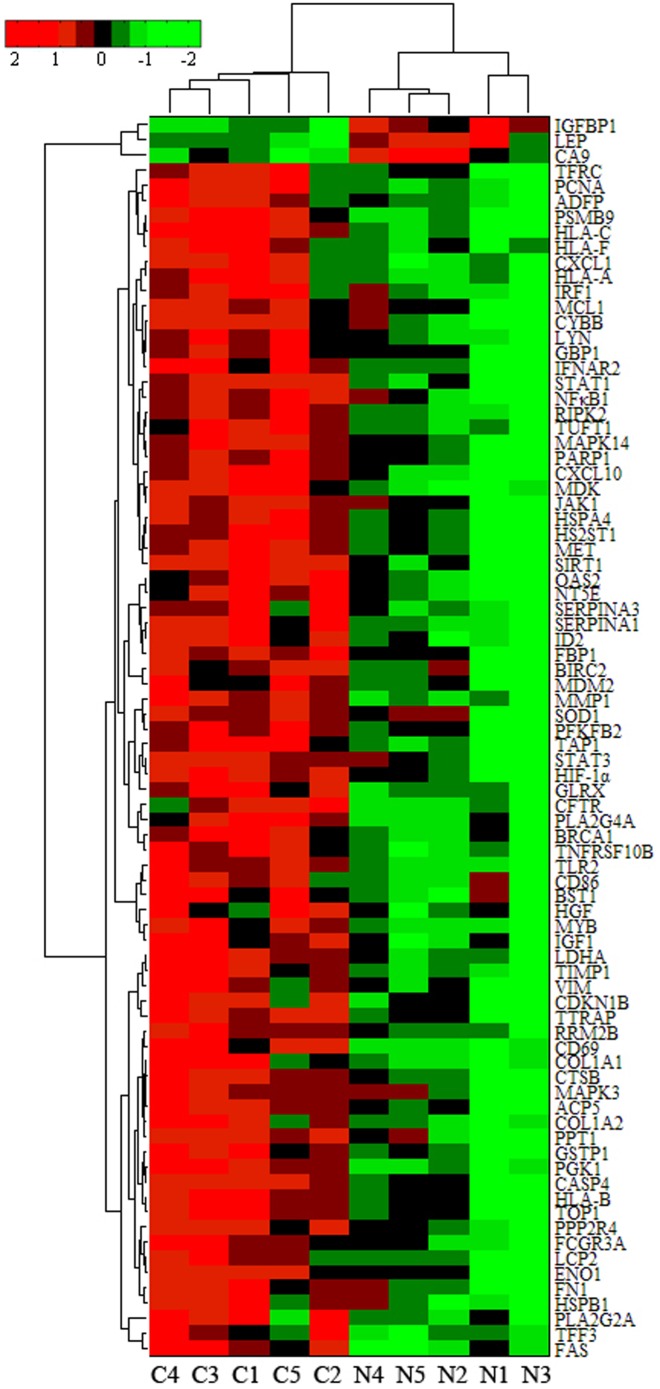
The bi-clusters analysis of these 82 differentially expressed genes in TF-gene regulatory network.Each row represents a gene and each column represents a sample, the “C” columns at the bottom represent cancer tissues, “N” columns represent normal tissues. >1 Red for high expression in cancer compared to normal and <1 green for low expression in cancer compared to normal ones.